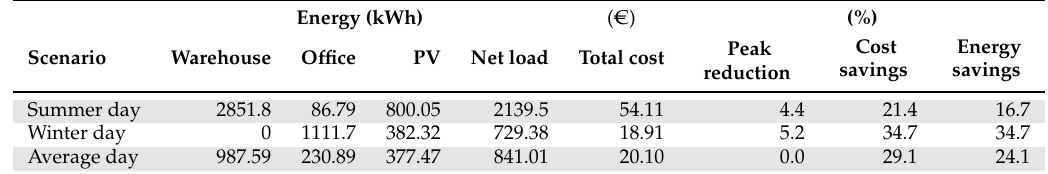
Table 10. Results for the cost minimization problem for three temperature scenarios in the Netherlands. Energy (kWh) ( A C)